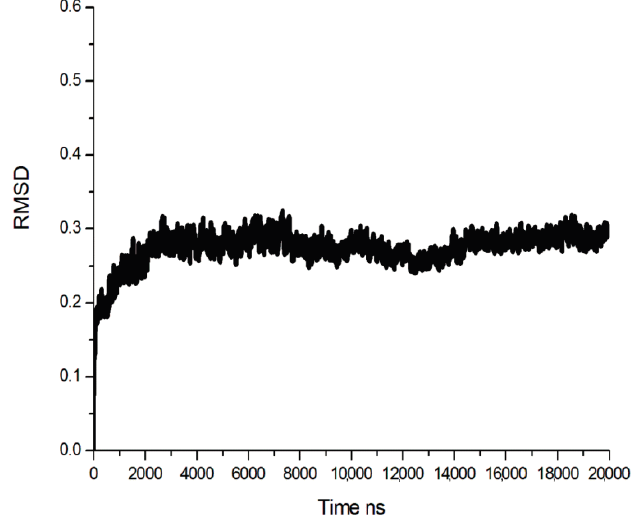
Figure 2. Root-mean-square deviation (RMSD) plot during 20-ns